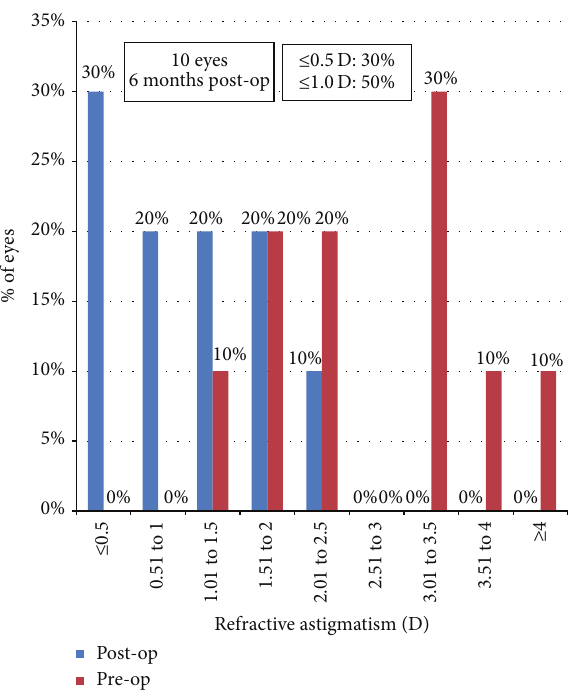
Figure 6: Predictability of refractive astigmatism correction 6m